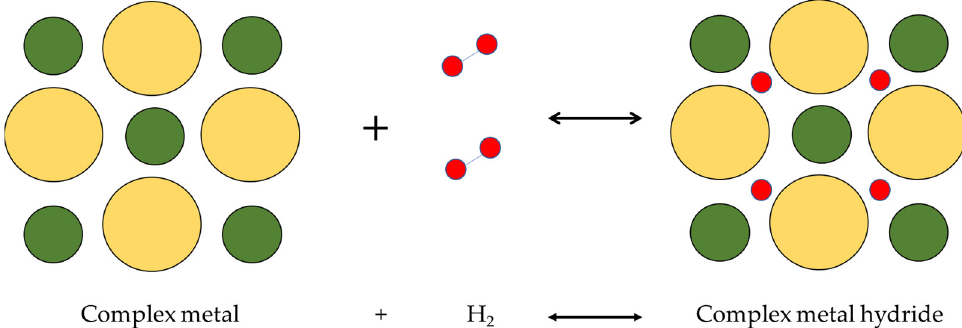
Figure 14. Complex hydrides process.